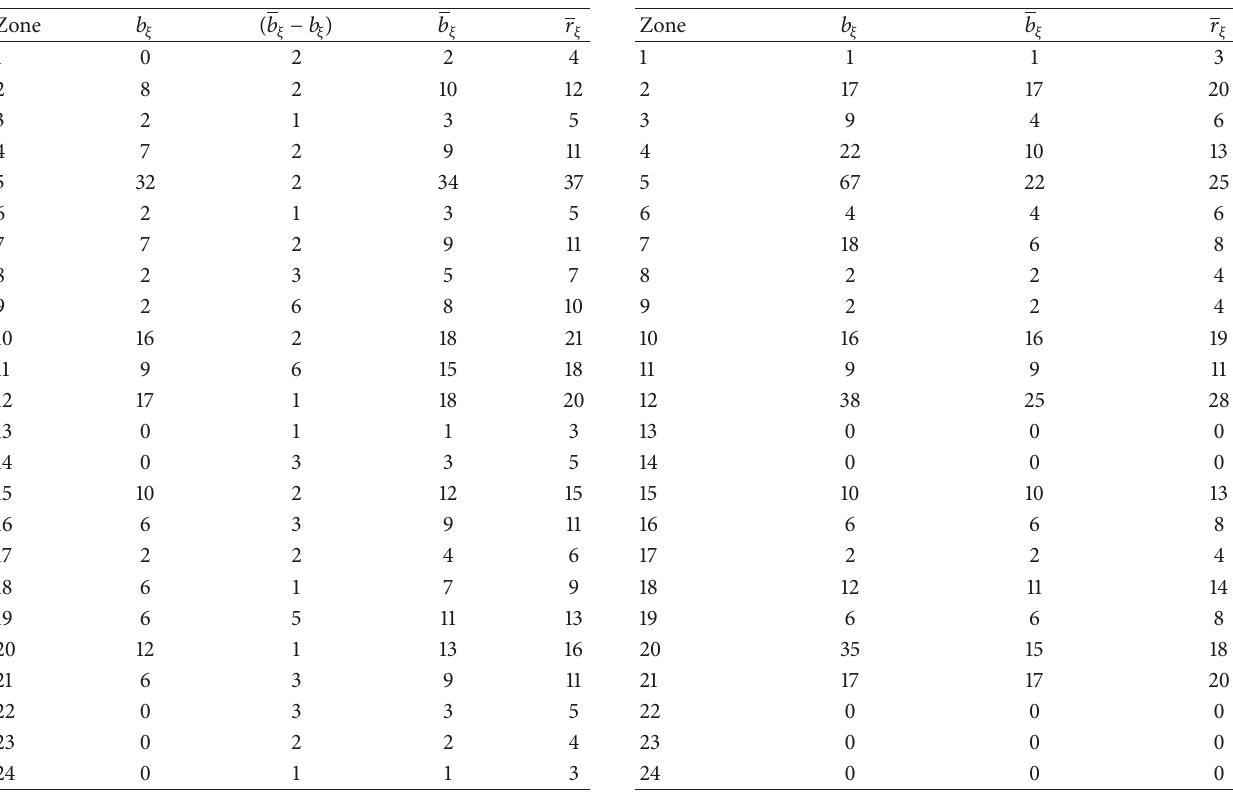
Table 2: Results for Scenario (1) , 𝑀 < 𝑅 . Table 3: Results for Scenario (2) , 𝑀 > 𝑅